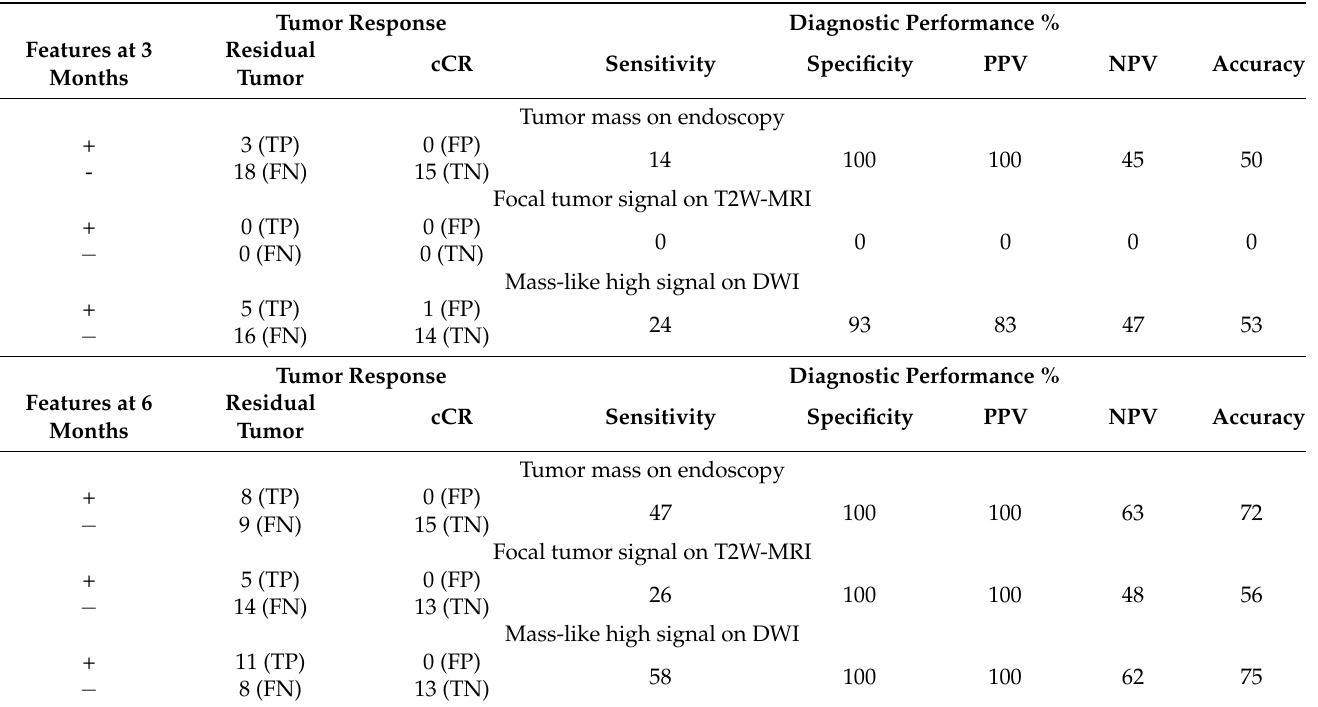
Table 3. Diagnostic performance of different features on endoscopy and MRI at 3 and 6 months after treatment with contact X-ray